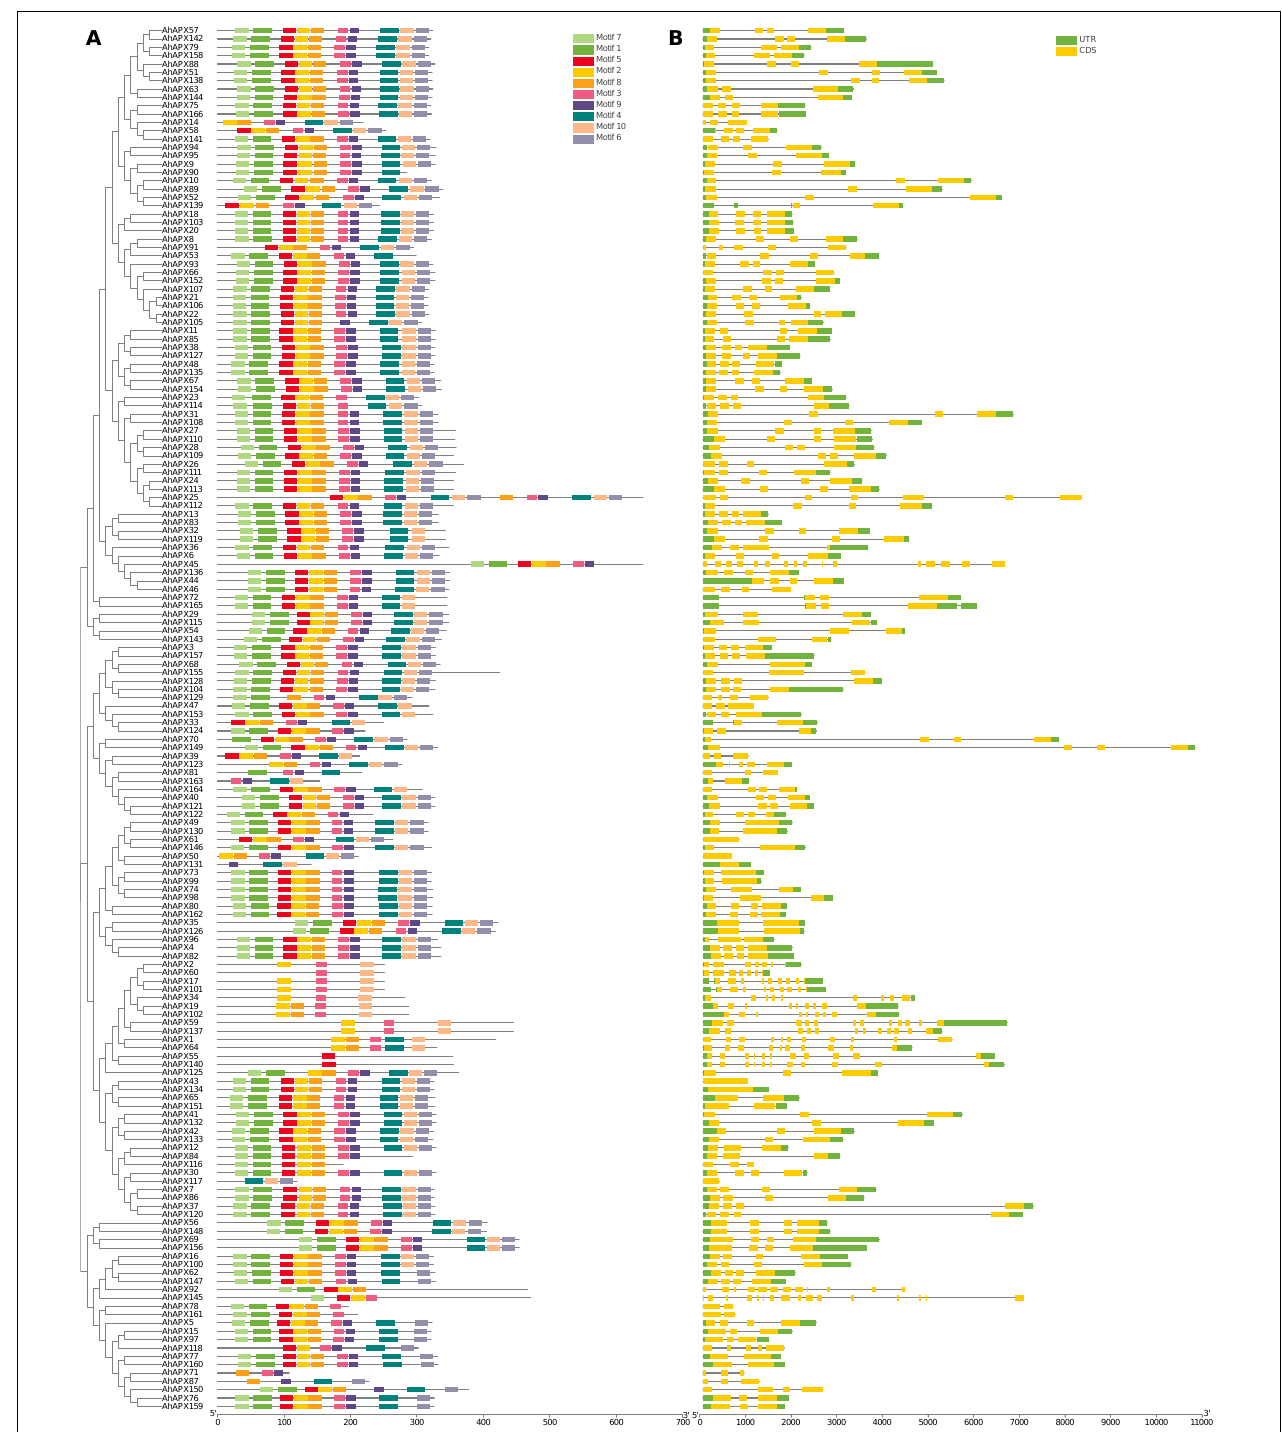
FIGURE 5 | The gene structure and motif analysis of the AhAPX genes. (A) Arrangements of predicted conserved motifs in AhAPXs . Unique color boxes exhibit individual motifs. (B) The gene structure of the AhAPXs . Light green color indicates the UTR regions; yellow color shows the CDS regions, and gray horizontal line displays the